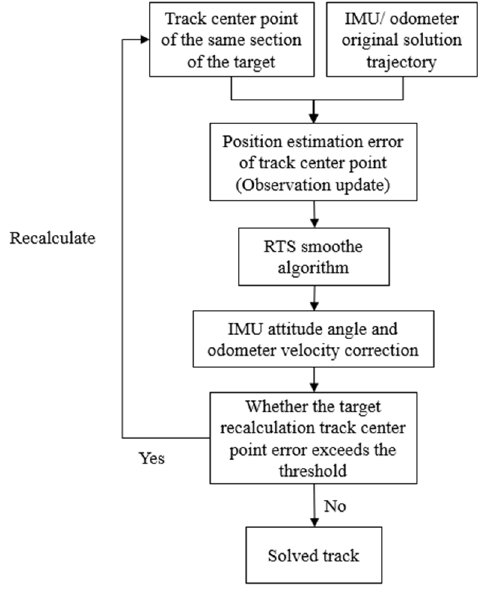
Figure 13. Trajectory correction.